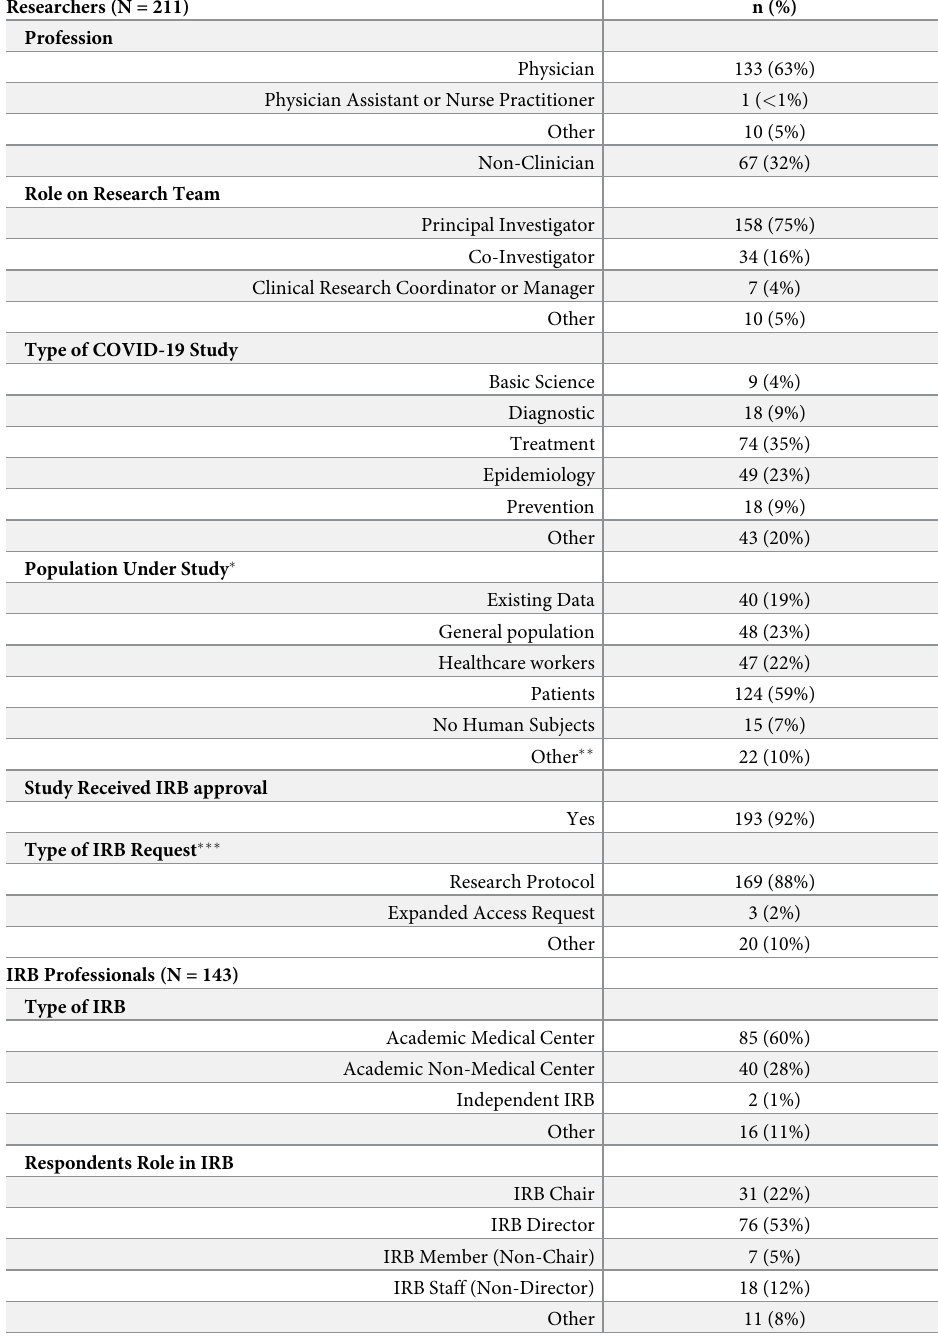
Table 1. Participant